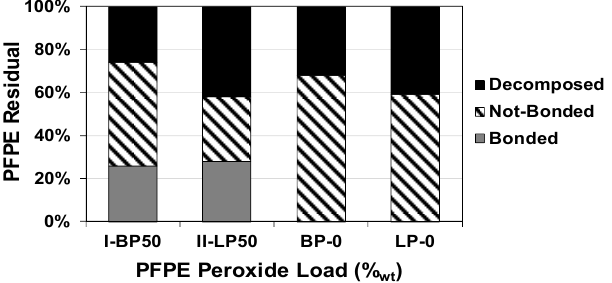
Figure 2. Bonded, non-bonded, and decomposed PFPE residuals after MW-CNTs functionalization compared to decomposition of pure PFPE peroxides.